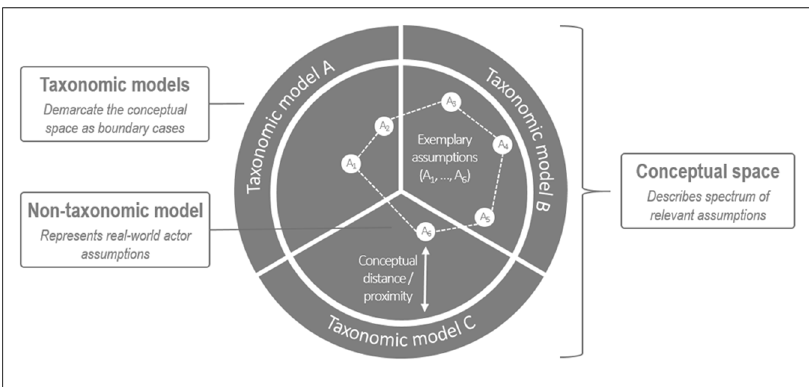
Fig. 2 The conceptual space. Taxonomic SSIMs are used as boundary cases. Real-world assumptions are de fi ned by their conceptual distance/proximity to the boundary cases. Real-world actors will typically hold several relevant assumptions. The totality of an actor's assumptions makes up the actor ’ s non-